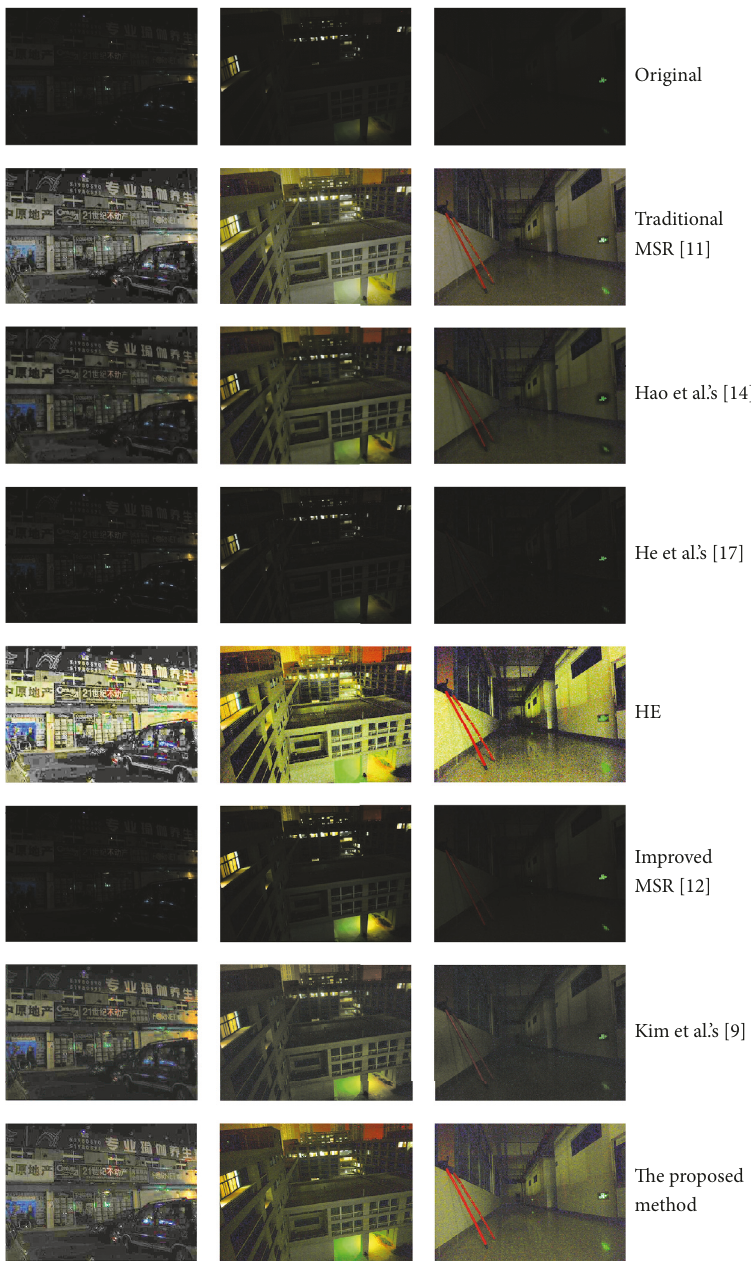
Figure 12: Results by different